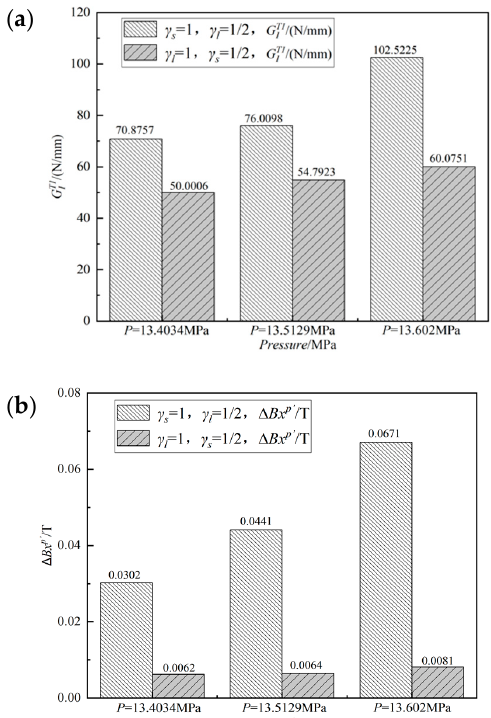
Figure 21. Variations of 𝛾 (cid:3039) and 𝛾 (cid:3046) in the second set of the example. ( a ) 𝐺 (cid:3010)(cid:3021)(cid:2869) − 𝛾 (cid:3039) , 𝐺 (cid:3010)(cid:3021)(cid:2869) − 𝛾 (cid:3046) , ( b ) ∆𝐵𝑥 (cid:3043)’ − 𝛾 (cid:3039) ,∆𝐵𝑥 (cid:3043)’ − 𝛾 (cid:3046) .